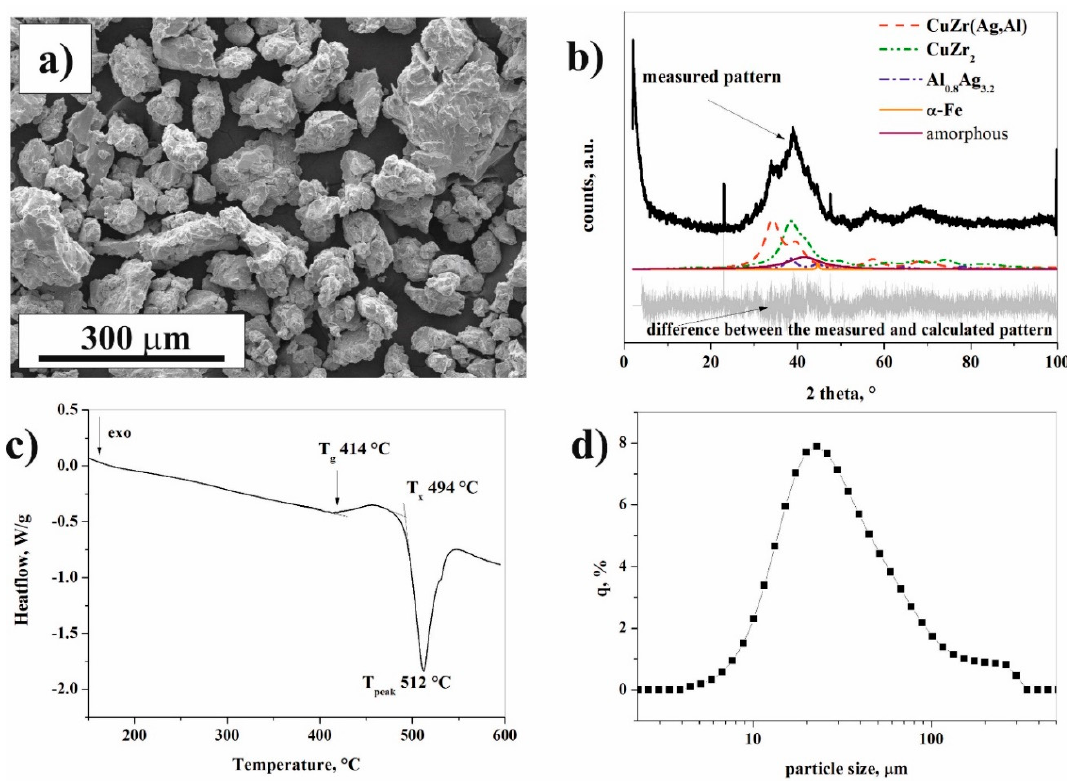
Figure 2. Scanning electron microscopic (SEM) images ( a ), XRD pattern ( b ), DSC thermogram ( c ), and particle size distribution ( d ) of the Cu 36 Zr 48 Ag8Al 8 powder. Table 1. Features of the amorphous phase and the crystallites based on the XRD of raw and milled